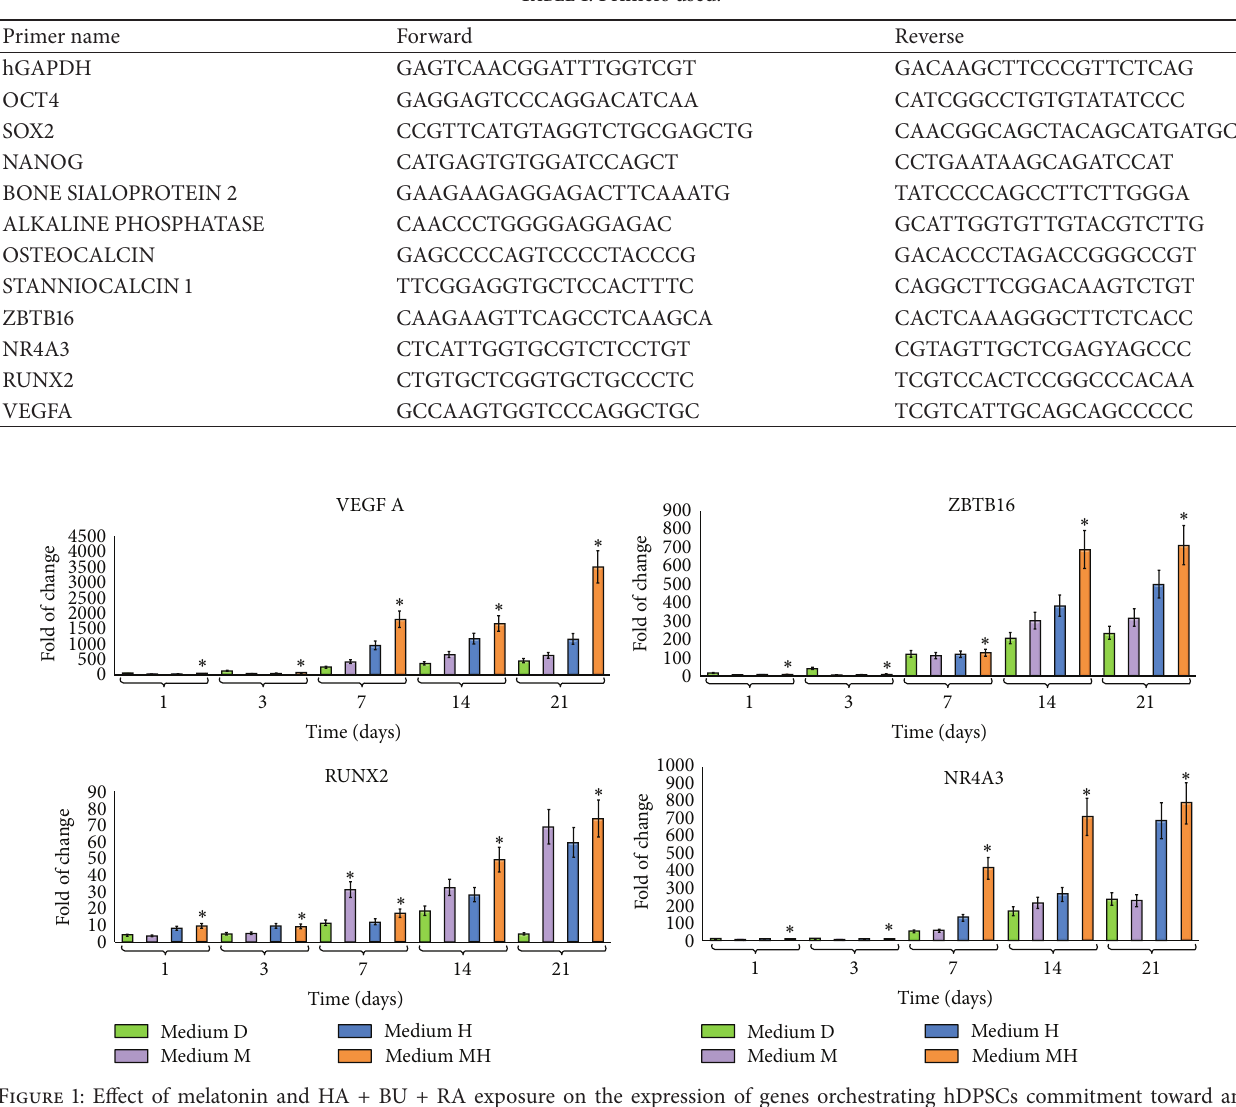
Table 1: Primers used.